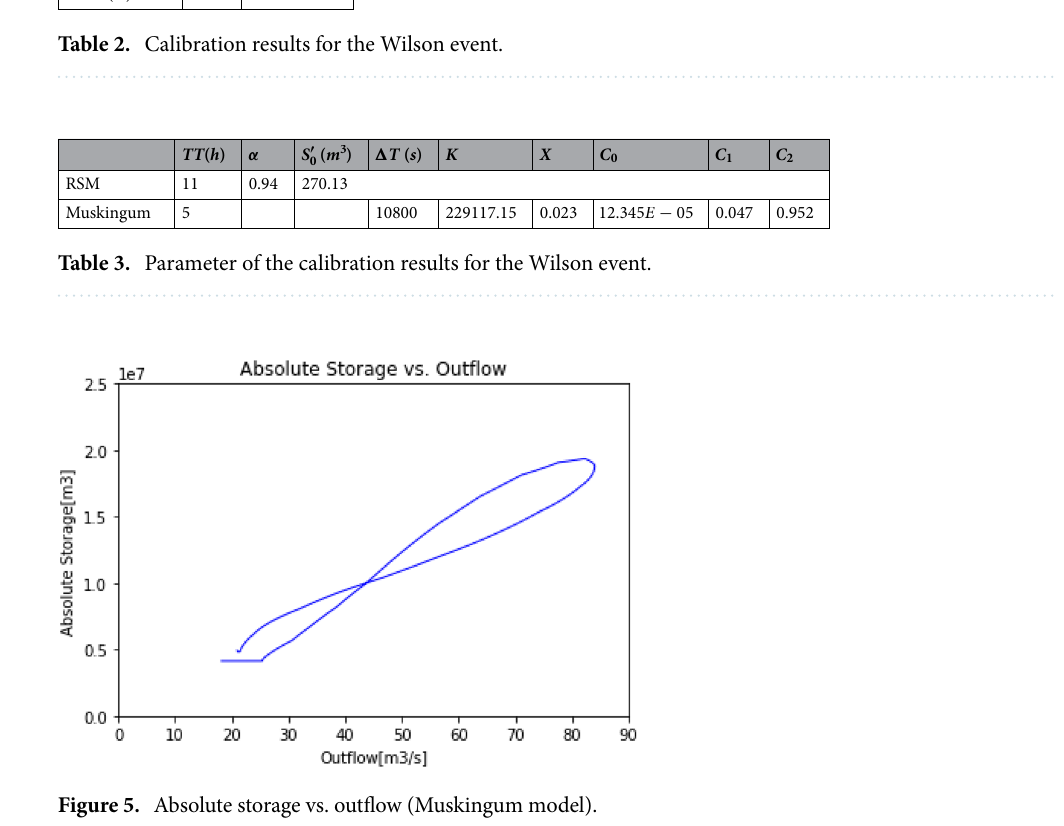
Figure 5. Absolute storage vs. outflow (Muskingum model).